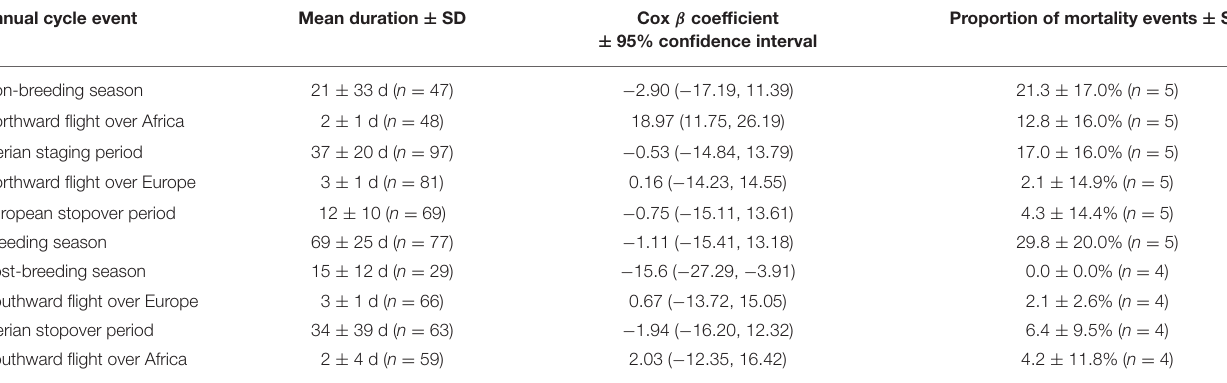
TABLE 2 | The duration, model-averaged β coefficients from an Andersen-Gill model, and total proportion of mortality events observed during each annual cycle event. Annual cycle